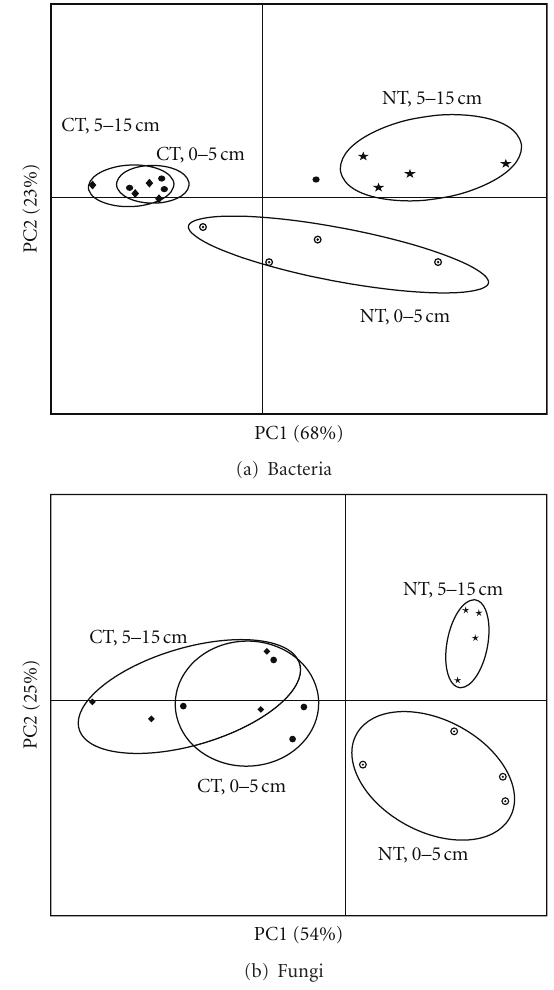
Figure 2: Principal components analyses of bacterial (a) and fungal (b) ARISA